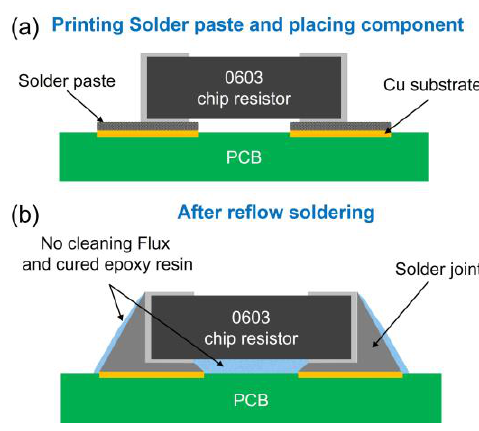
Figure 2. Solder joint of 0603 chip resistor schematic diagram: ( a ) Printing solder paste and placing component; ( b ) Solder joint after reflow soldering.